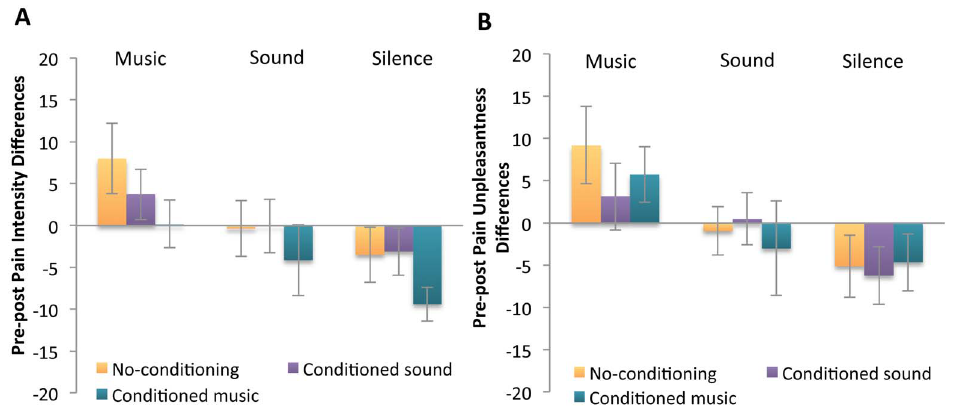
Figure 3. Average pain intensity and unpleasantness changes, all original groups. N=35. Shown here are pre (baseline) minus post (testing) pain difference scores (mean 6 SEM); positive values indicate analgesia. Panel A displays Pain Intensity, panel B displays Pain Unpleasantness.